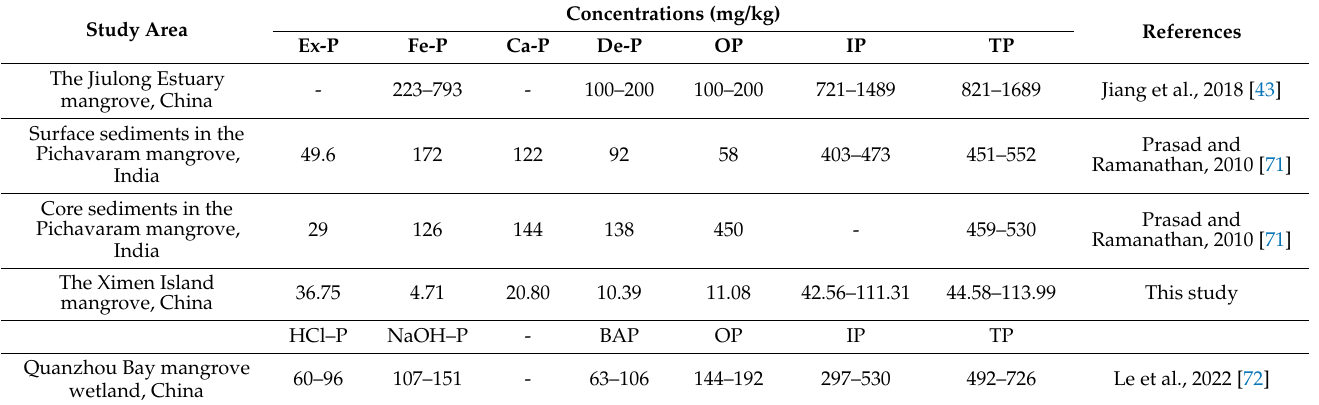
Table 3. Comparison of the concentrations of sedimentary P species in the present study with those in other mangrove areas reported in the